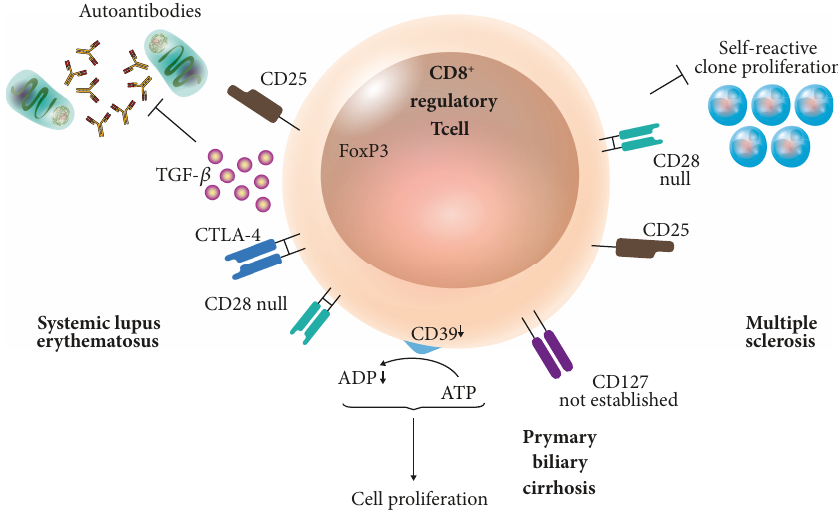
Figure 3: Participation of CD8 + Treg lymphocytes in autoimmune diseases. During SLE, antibody production is eliminated thanks to the suppressive activity of TGF- β -producing CD8 + CD25 + FoxP3 + Treg lymphocytes, which are induced after an autologous transplant of hematopoietic progenitor cells, achieving the remission of the disease. On the other hand, during primary biliary cirrhosis, CD8 + CD28 − T lymphocytes show decreased CD39 expression and fail to inhibit cell proliferation, promoting the severity of this autoimmune disease. In human multiple sclerosis, therapy with IFN- β regulates the immune system by reducing autoreactive T cell clones and increases CD8 + CD25 + CD28 − regulatory T cells. SLE: systemic lupus